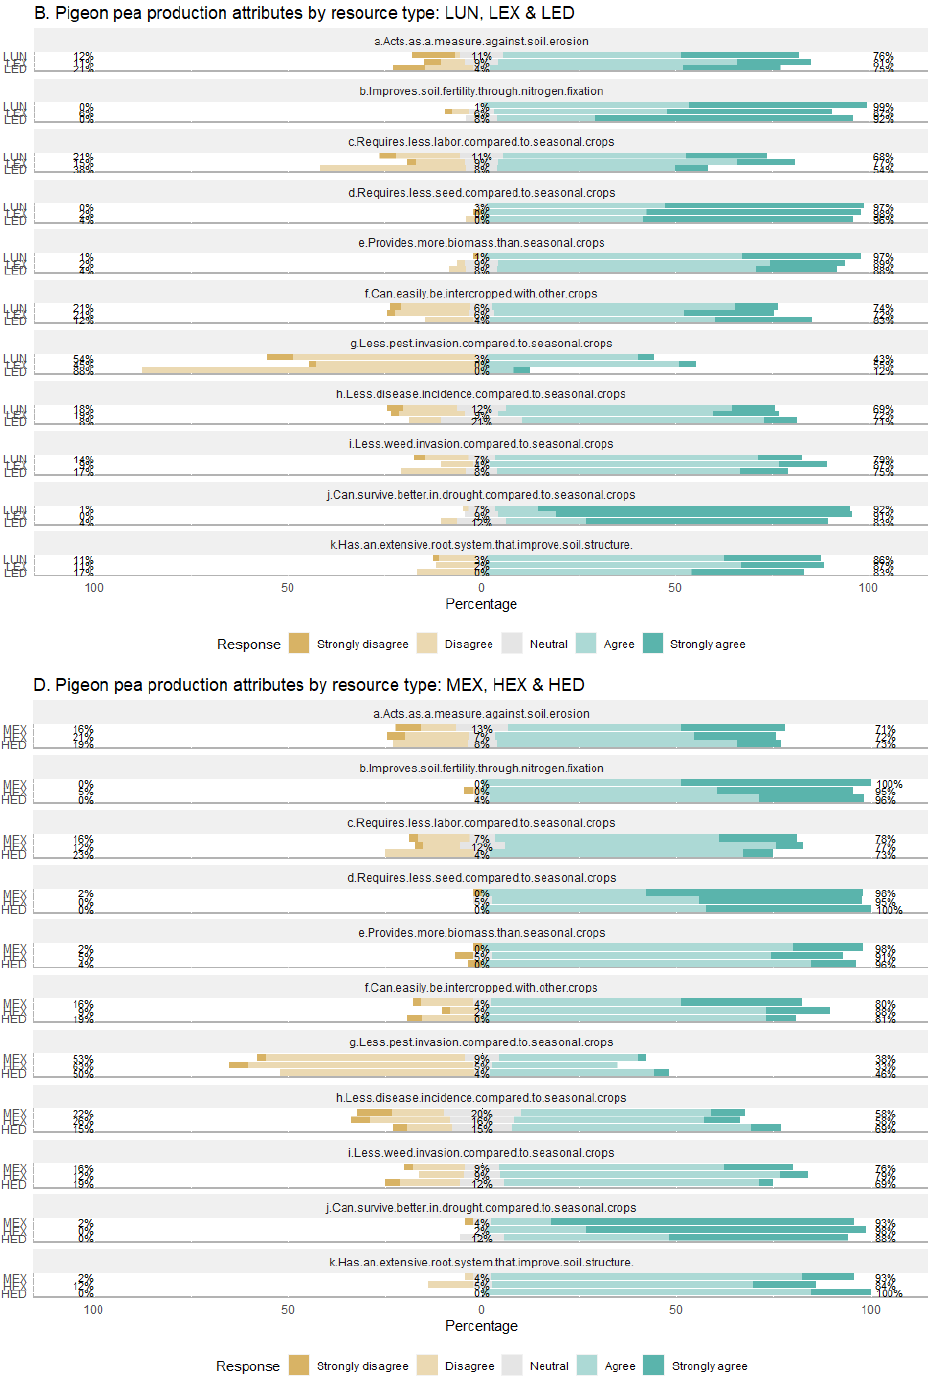
Figure 4. Perception of smallholders on pigeon pea, ( n = 256). Likert type rate 1 = strongly disagree, 2 = disagree, 3 = neutral, 4 = agree, and 5 = strongly agree. The percentage on the left side indicate the share of respondents answering with 1 or 2 on the Likert scale. The percentage in the middle indicate the share of respondents answering with 3 (neutral). The percentages on the right side indicate the share of respondents answering with 4 or 5. ( B ) and ( D ) are production-related attributes across low, medium and high resourced farm types.